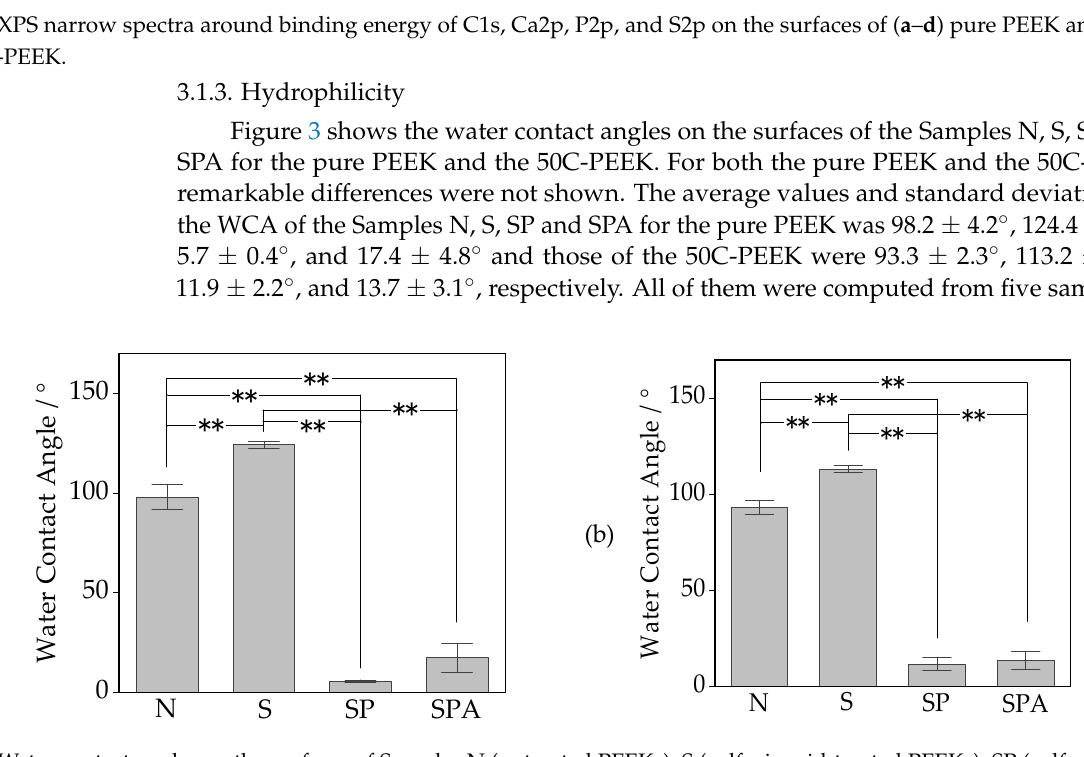
Figure 3. Water contact angles on the surfaces of Samples N (untreated PEEKs), S (sulfuric acid-treated PEEKs), SP (sulfuric acid + oxygen plasma-treated PEEKs), and SPA (sulfuric acid + oxygen plasma + modified-SBF-treated PEEKs) for ( a ) pure PEEK and ( b ) 50C-PEEK. The symbol ‘**’ indicates p < 0.01 and no symbol p > 0.05 by a one-way ANOVA, followed by Tukey’s test.